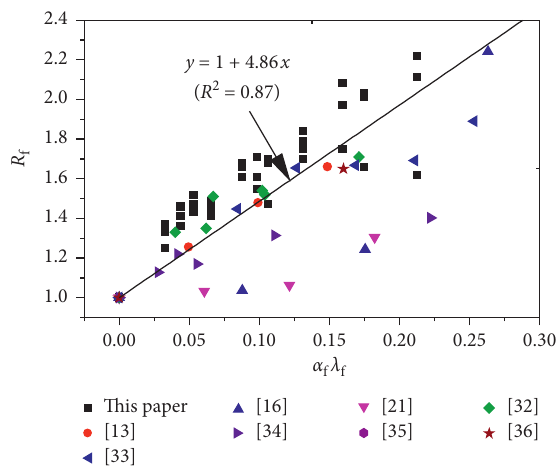
Figure 9: Relationship between R f and α f λ f . Table 6: Calculated results and the comparison between calculated results and test results of mechanics strength. Mixture